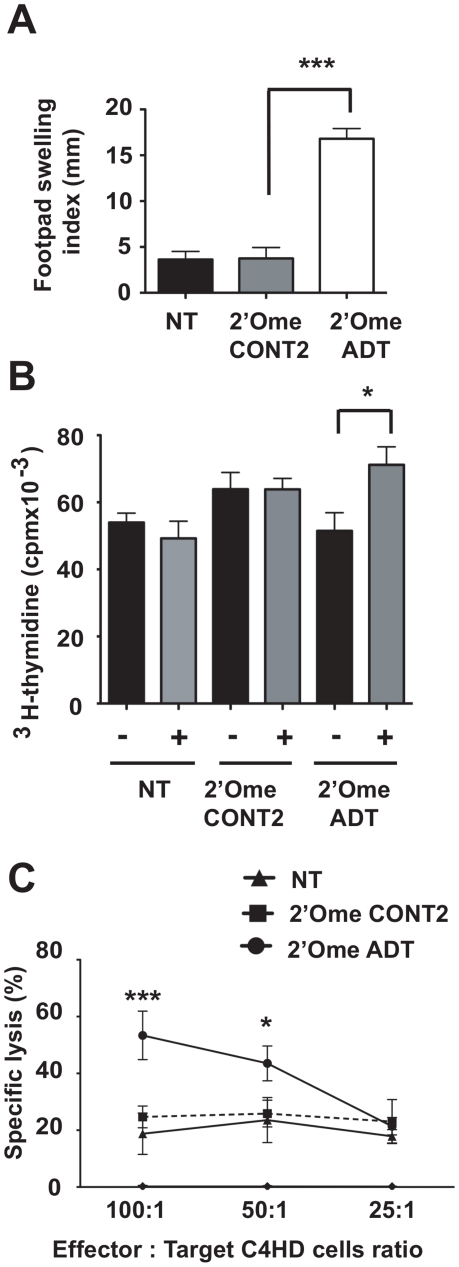
Immunization with C4HD cells treated with IGF-IR siRNAs.(A) Delayed-type hypersensitivity (DTH) response. BALB/c mice (n = 10) were immunized with three injections of irradiated C4HD cells (black bar) or irradiated 2′-O-methyl ADT siRNA (white bar) or 2′-O-methyl CONT2 siRNA (grey bar) transfected C4HD. NT, non-transfected cells. Data are presented as mean ± SEM; *** P<0.001. (B) Proliferation of splenocytes isolated from immunized mice. Incorporation of 3H thymidine was measured with isolated splenocytes co-cultured in the presence (+) or the absence (−) of C4HD cells preincubated with mitomycin C. Data are presented as mean ± SEM; * P<0.05. (C) Analysis of cytotoxic activity of splenocytes from immunized mice using a standard 51Cr release assay. Splenocytes (E) from mice immunized with 2′-O-methyl ADT (•) or 2′-O-methyl CONT2 (▪) transfected C4HD, or with irradiated C4HD cells (▴) were co-cultured with C4HD as target cells (T) at indicated E/T ratios. Mean ± SEM; * P<0.05; *** P<0.001.